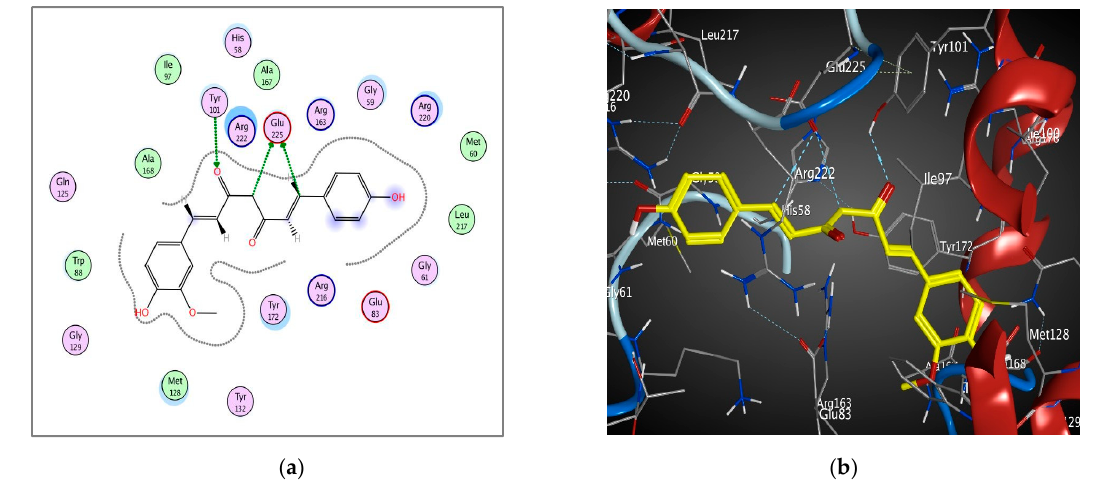
Figure 6. 2D diagram ( a ) and 3D representation ( b ) showing the binding mode of curcumin (yellow) with 1KI7 thymidine kinase binding pocket.